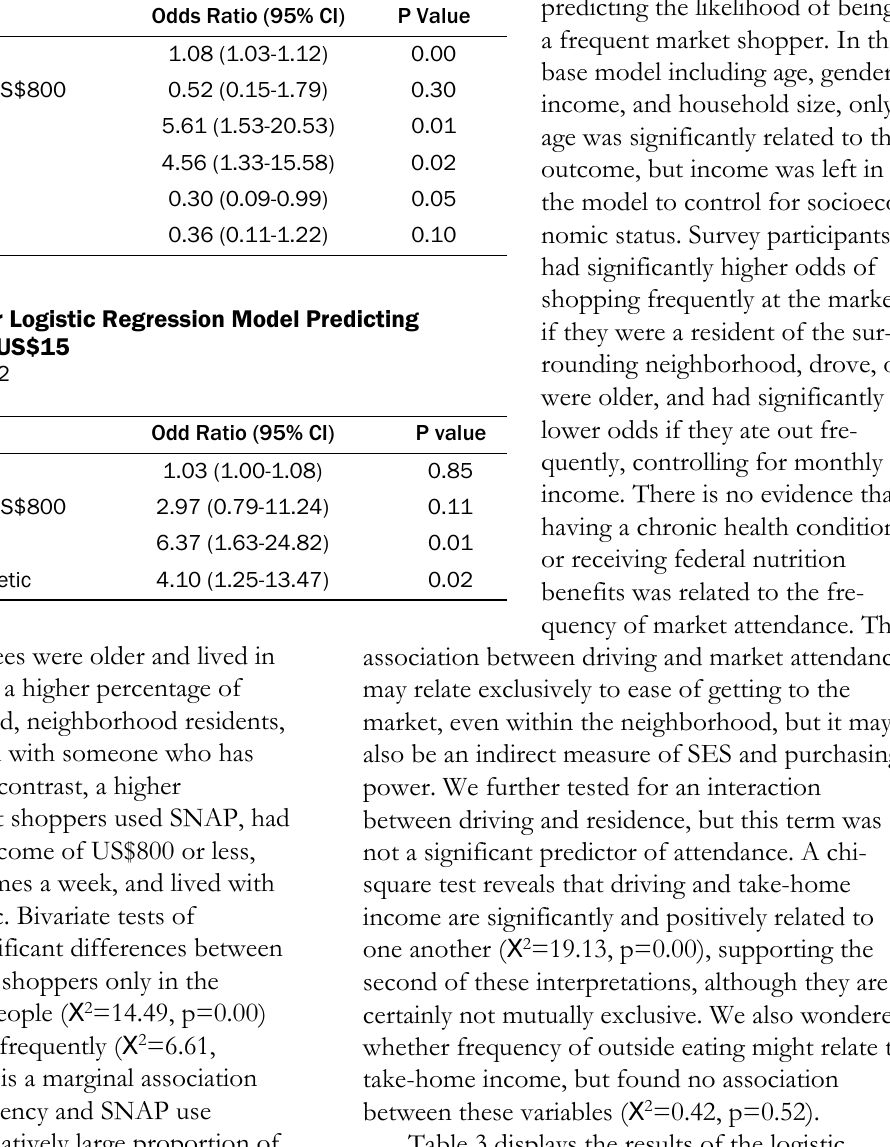
Table 2. Odds Ratios and 95% Confidence Intervals for Logistic Regression Model Predicting High Market Attendance